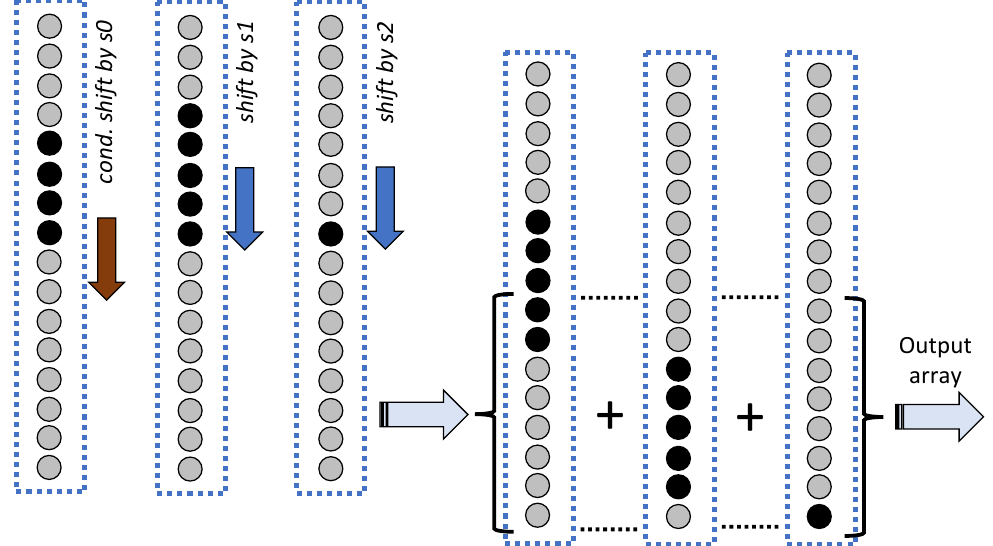
Figure 5. Diagram for the packing operation: the defragmented bunch is copied in the upper half array; as the array goes through a pipelined structure, shifting and zero-filling operations modify the array. Black bullets highlight the useful information, whereas gray bullets represent the zero values that are inserted at the defragmentation or after any shift that frees the topmost locations at the packing